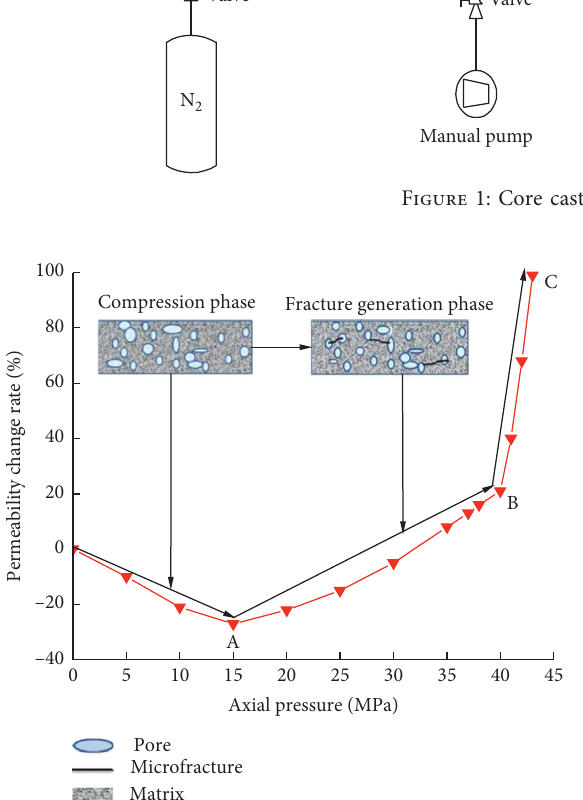
Figure 2: Diagram of permeability change with axial